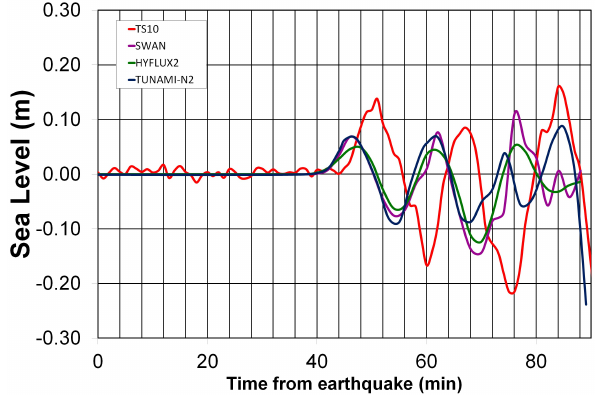
Fig. 18. Time series of sea level elevation from model forecasts for the earthquake compared to TNBL.